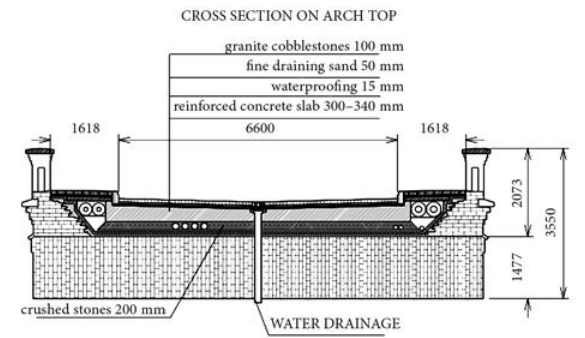
Fig. 12. Characteristic of the cross sections on the pier and on arch top